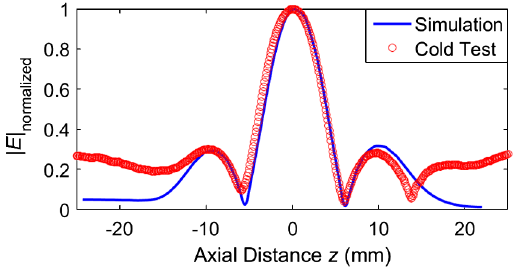
FIG. 19. The axial E field profile of the HPBG-Pin structure by bead pull measurement.